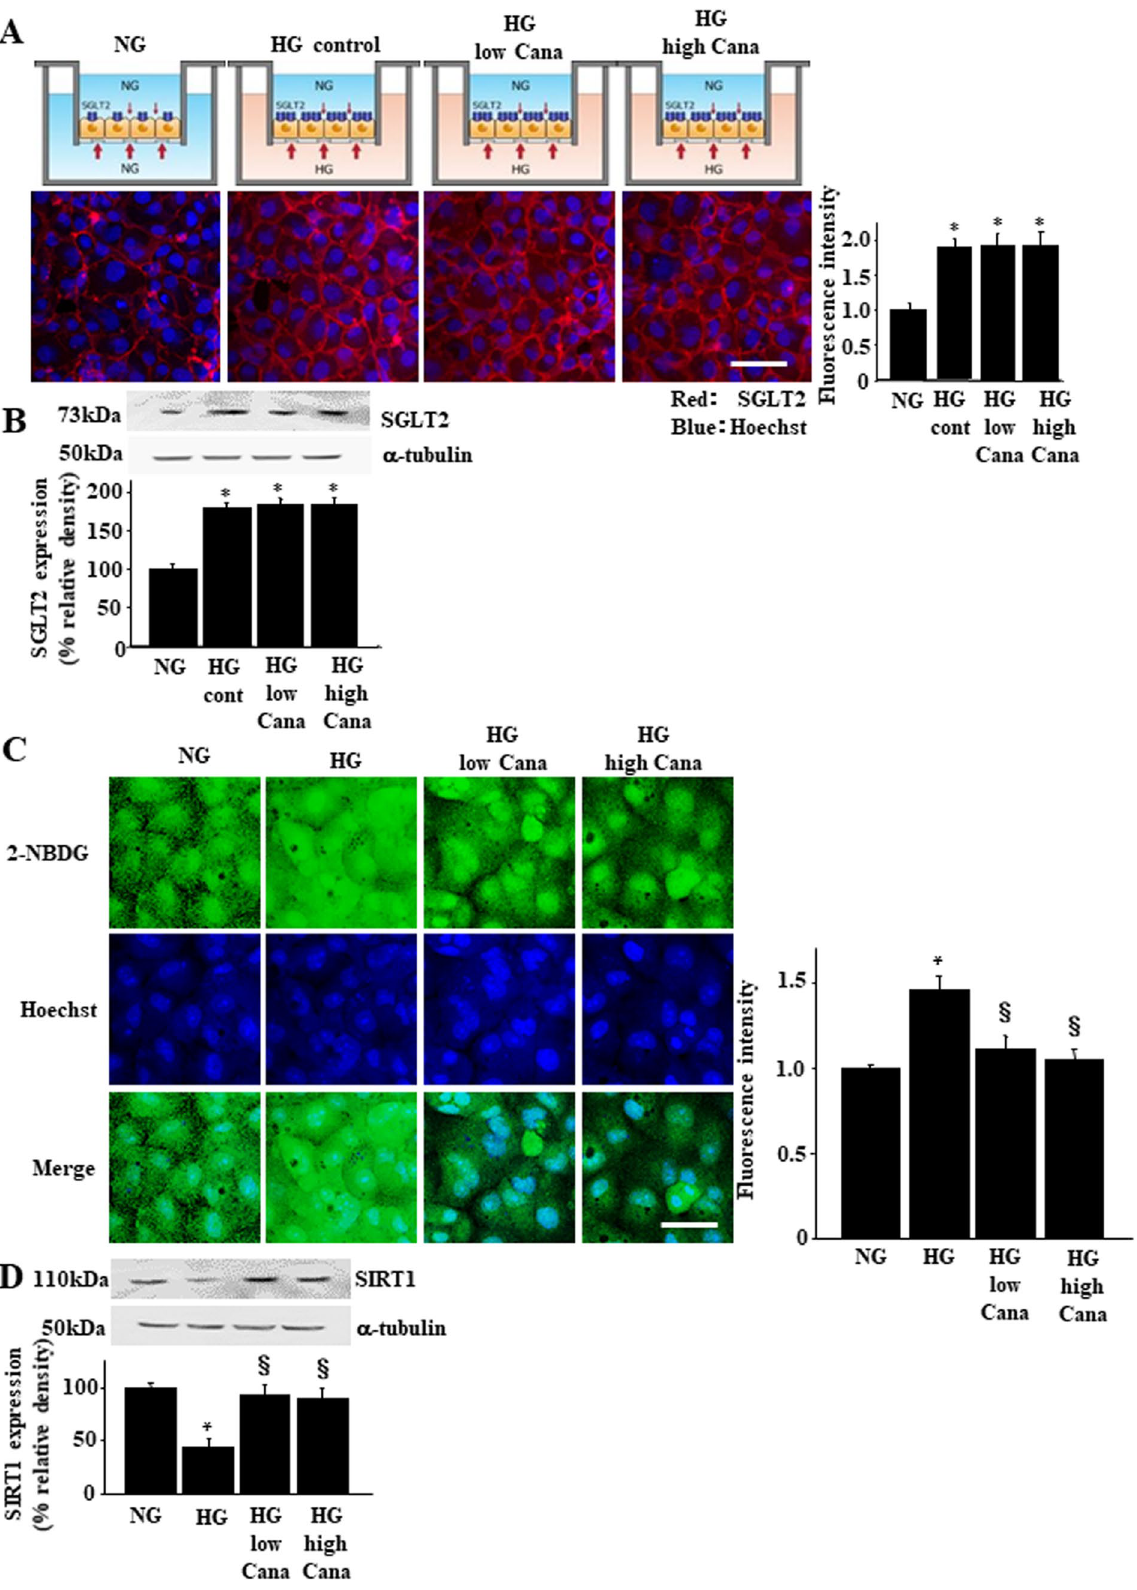
Figure 5. Effect of Cana on the expression of SIRT1 and its downstream signaling components. Confluent growth-arrested LLC-PK1 cell monolayers were stimulated with HG medium on the basolateral side for up to 24 h with or without pretreatment with Cana in the apical side. Immunofluorescence analysis ( A ) and immunoblotting ( B ) for SGLT2 expression in LLC-PK1 cells. The relative quantification of the SGLT2 immunofluorescence was measured and is indicated in the bar graphs. Scale bar, 50 µ m. * P < 0.05 vs. NG